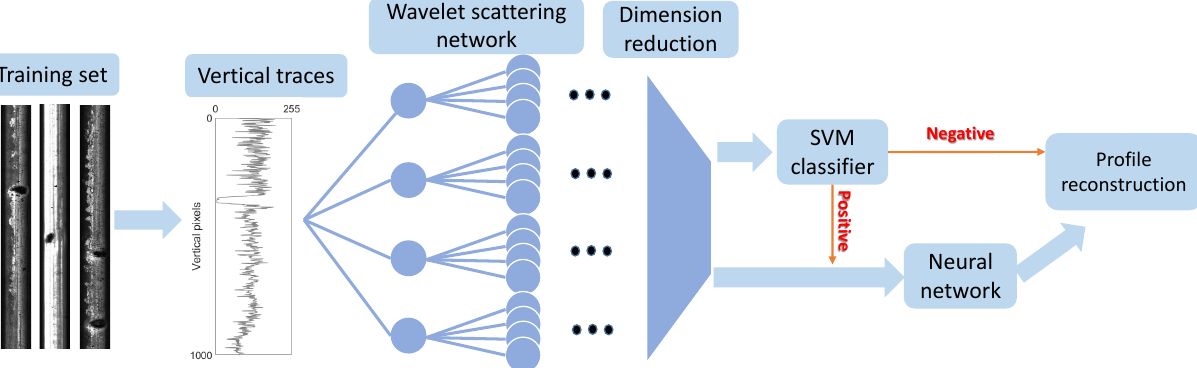
Figure 4. The machine learning framework for railhead defect identification.